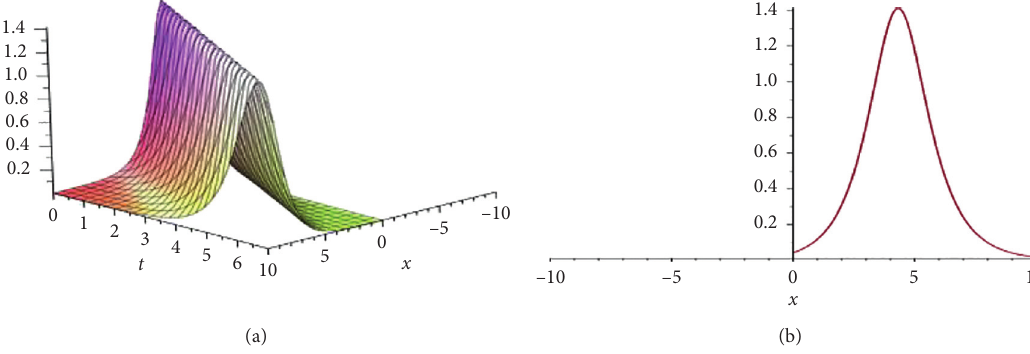
Figure 4: Soliton wave shape of (98) when β � 1, k � 1, c � − 1, λ � − 1, α � 0 . 95, − 10 ≤ x ≤ 10, and 0 ≤ t ≤